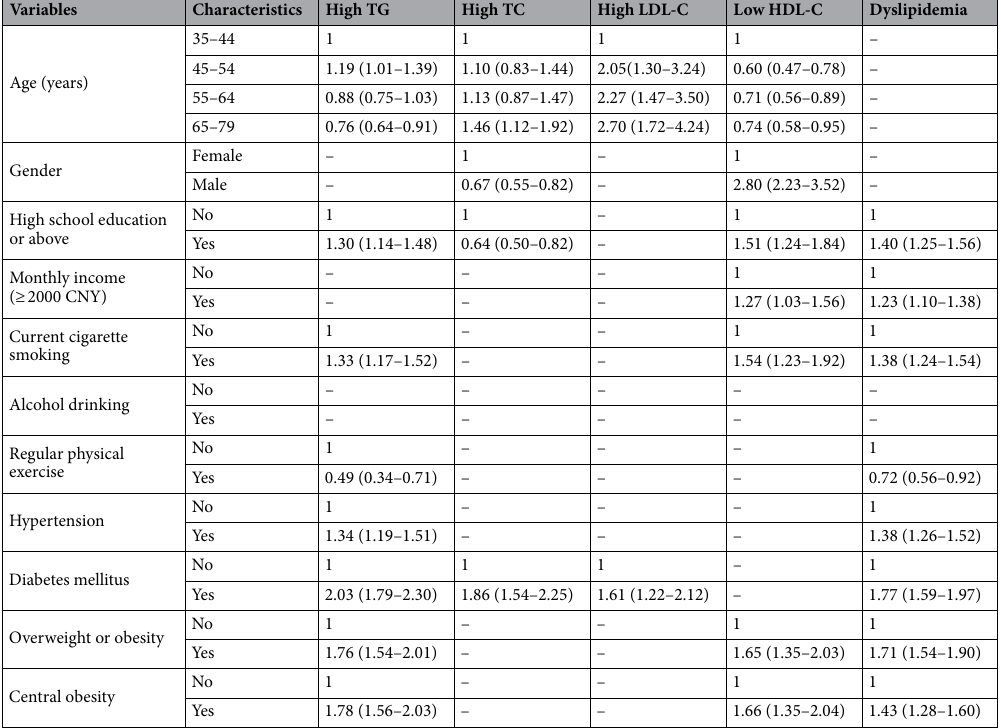
Table 4. Multivariable–adjusted OR s and 95% CI for different definitions of dyslipidemia among adults aged 35 years or older in Southwestern China. “–” indicates that an independent variable was not associated with the dependent